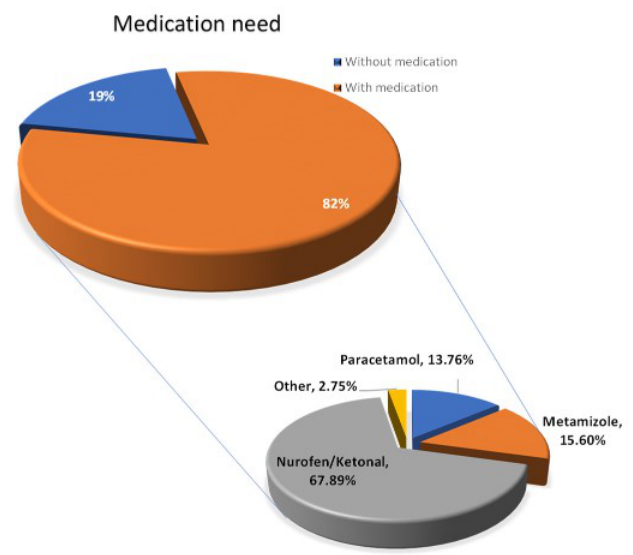
Figure 4. Distribution of patients depending on the type and the need for